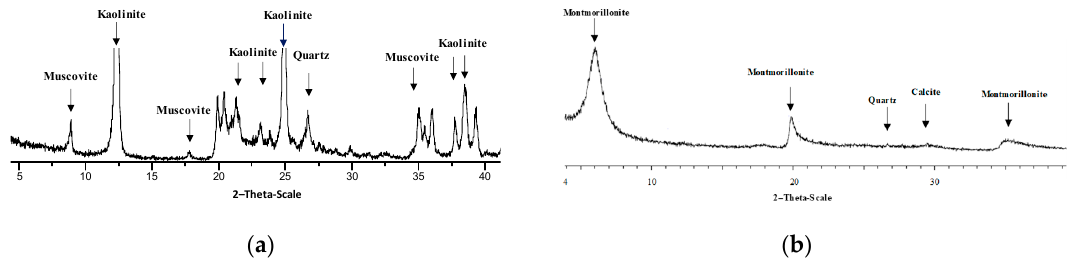
Figure 1. X-ray di ff raction patterns: ( a ) Spwt kaolin; ( b ) Figure 1. X-ray diffraction patterns: ( a ) Spwt kaolin; ( b ) Bentonite. Table 1. Chemical composition of clays.